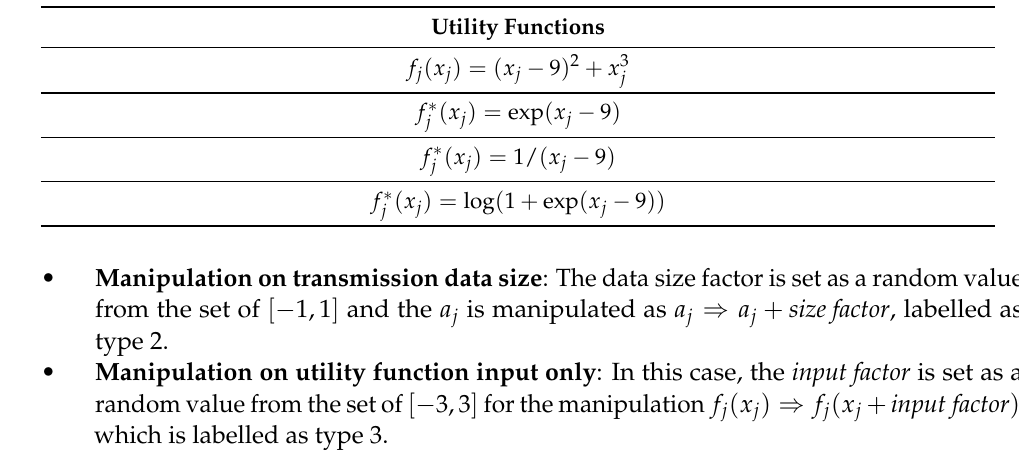
Table 2. Utility functions set.